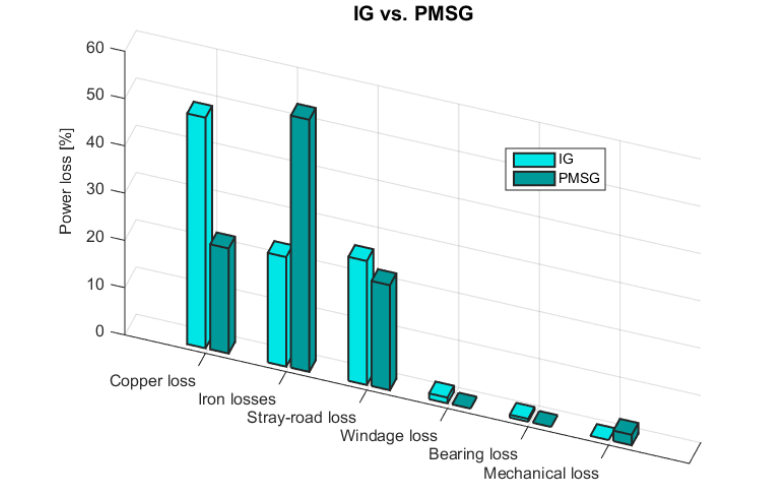
Figure 27. Relative power loss estimation for induction generator and permanent magnet generators, based on the information published in